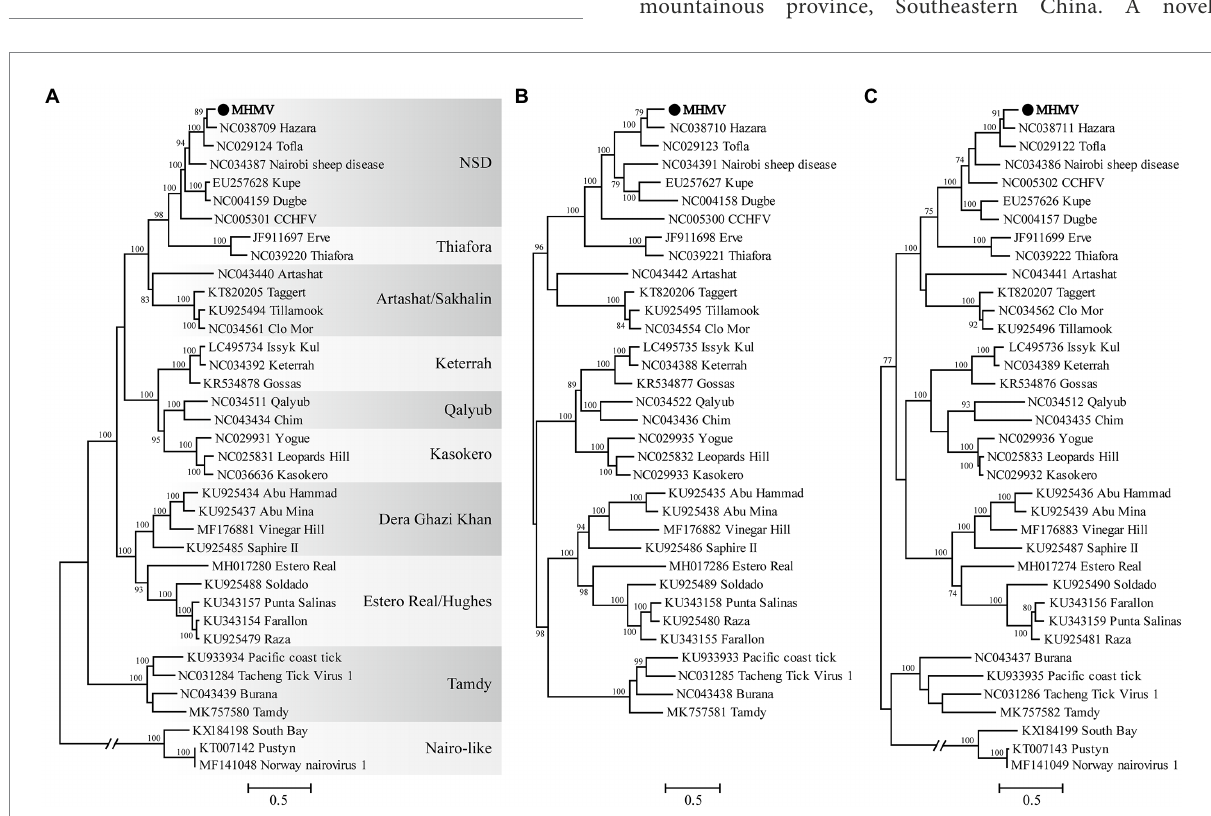
FIGURE 3 ML phylogenetic trees based on the amino acid sequences deduced from L, M, and S segments of Meihua Mountain Virus (Black dots) and other representative orthonairoviruses. (A) Tree inferred from the RdRp amino acid sequences. (B) Tree inferred from the GPC amino acid sequences. (C) Tree inferred from the N protein amino acid sequences. Genogroup assignments are indicated with differential shading patterns. Bootstrap support values ≥ 70% are indicated. Sequences are identified by their GenBank accession numbers, followed by the virus name. GenBank accession numbers of sequences used in the alignments are listed in Supplementary Table